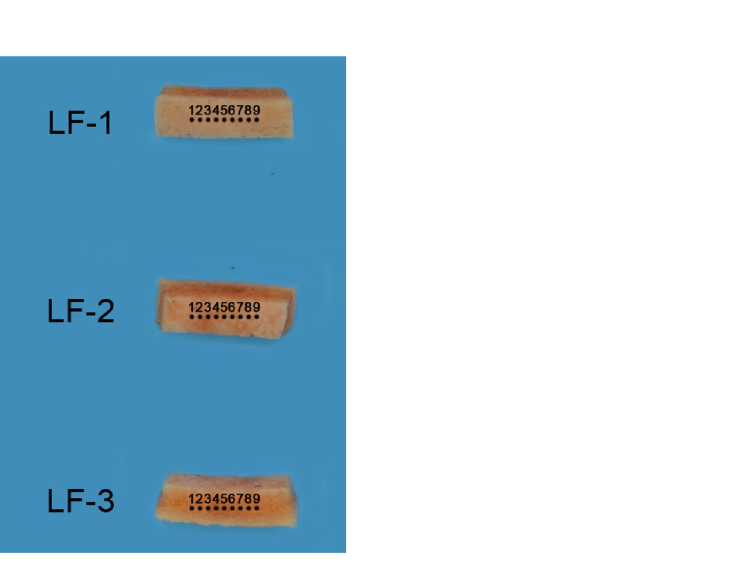
Figure 2. Physical diagram of CS samples at different ages. Samples ( a , b , c , d , and e ) were 0.047, 3, 8, 51, and 77 years of age, respectively.